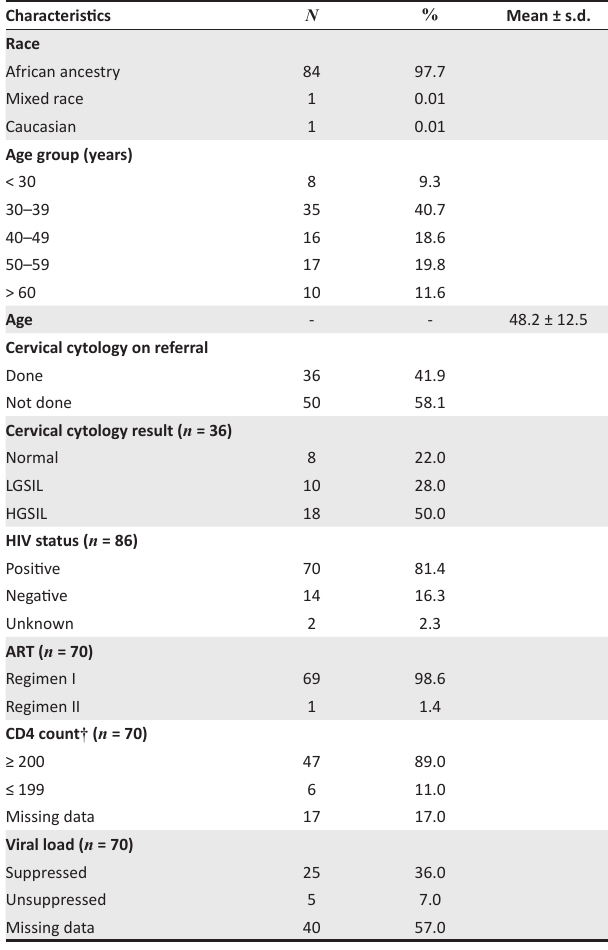
TABLE 2: Demographics and clinical details of women with vulvar cancer ( n = 86).